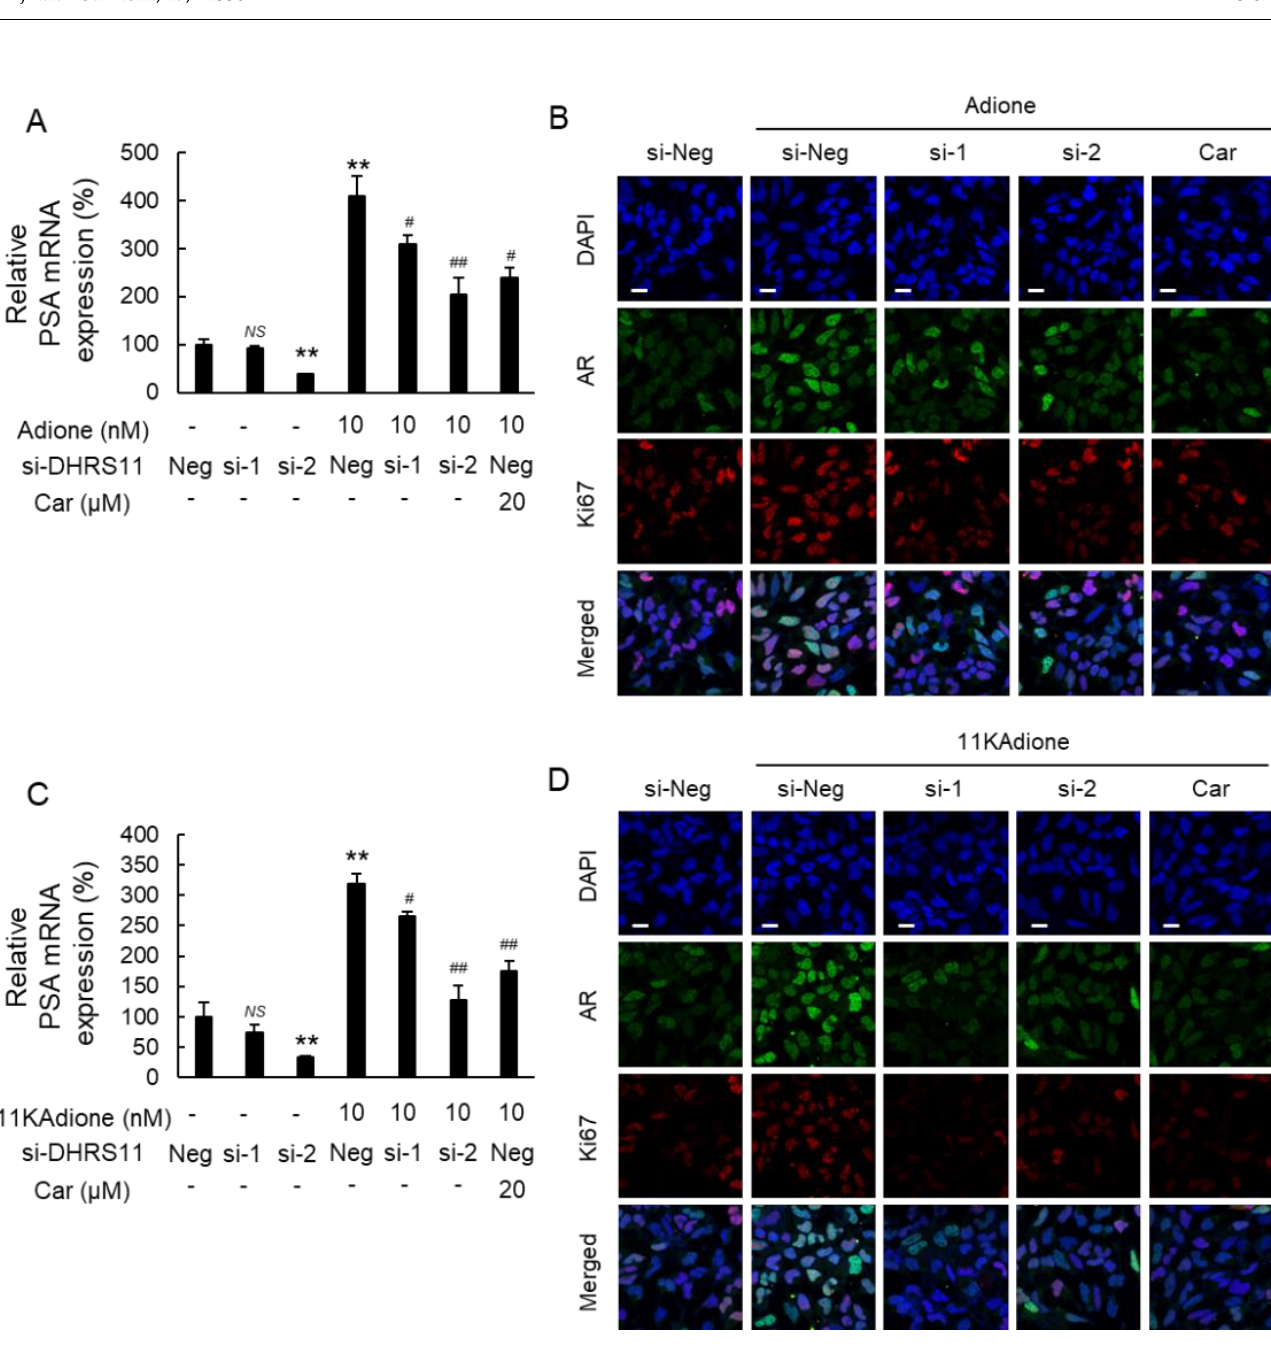
Figure 3. Effects of DHRS11 knockdown on androgen signaling induced by Adione or 11KAdione in C4-2 cells. The cells were treated with Adione ( A , B ) or 11KAdione ( C , D ) 24 h after transfection with DHRS11 siRNA (si-1 or si-2) or universal negative siRNA (Neg) and incubated for another 24 h. Treatment with a DHRS11 inhibitor, carbenoxolone (Car), was performed 2 h before the treatment with Adione or 11KAdione. ( A , C ) PSA expression. The expression levels analyzed by RT-qPCR. ** p < 0.01, NS p > 0.05 denotes significantly different from the cells treated with DMSO alone. ## p < 0.01, # p < 0.05 denotes significantly different from the cells treated with 10 nM Adione or 11KAdione alone. ( B , D ) Nuclear expression of AR and Ki67. AR (green), Ki67 (red) and DNA (blue) were visualized by immunofluorescence using the antibodies against AR and Ki67 and DAPI, respectively. Merged images are also shown. Scale bar indicates 20 µ